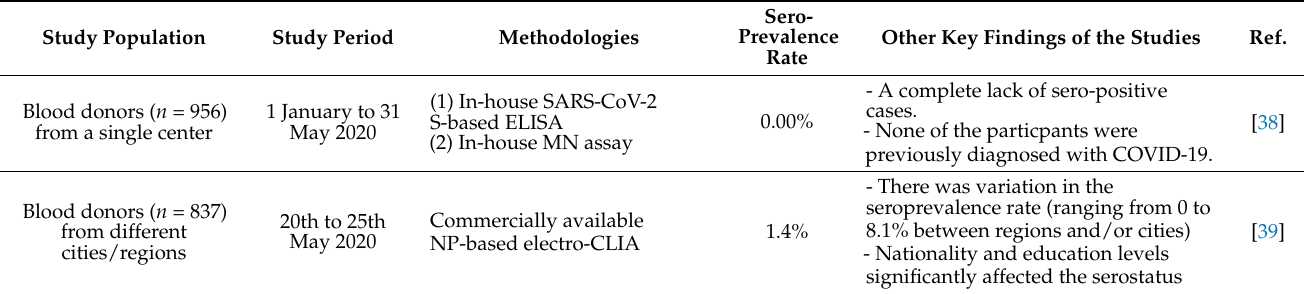
Table 2. Summary of seroprevalence studies of COVID-19 in Saudi Arabia. The targeted study population, study period, immunoassays utilized, the seroprevalance rates, and other key findings are shown. Study